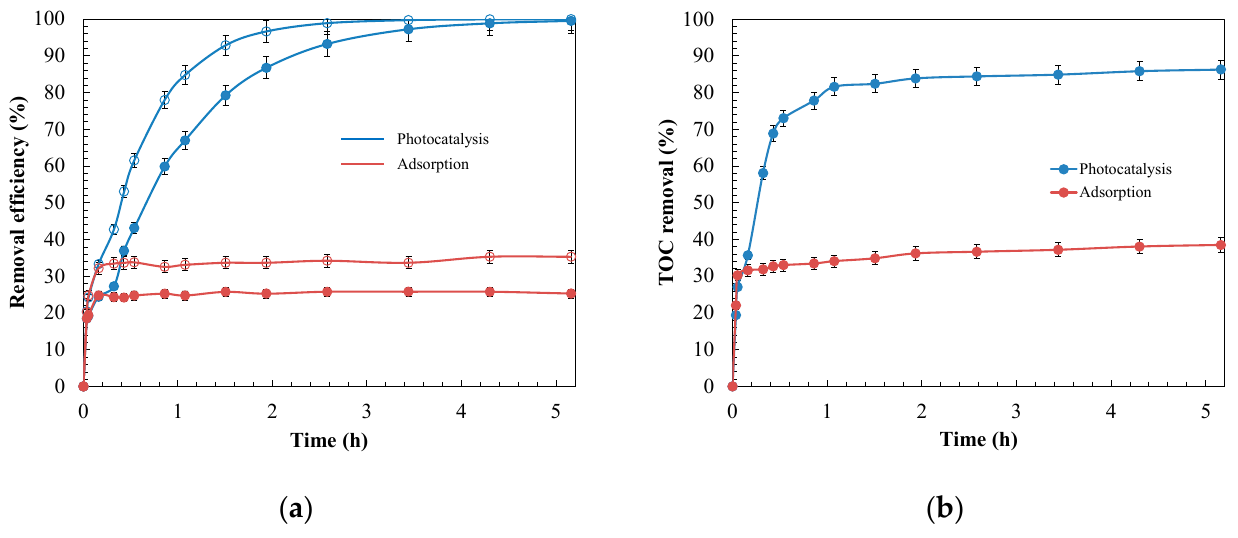
Figure 10. Removal efficiency of adsorption and photocatalysis processes for 12.0 mg L − 1 of ANI ( ○ ) and BTH ( ● ) at pH = 9.0 with 0.9 g L − 1 composite MnO 2 /GAC-3. Evolution: ( a ) primary degradation; ( b ) mineralisation.